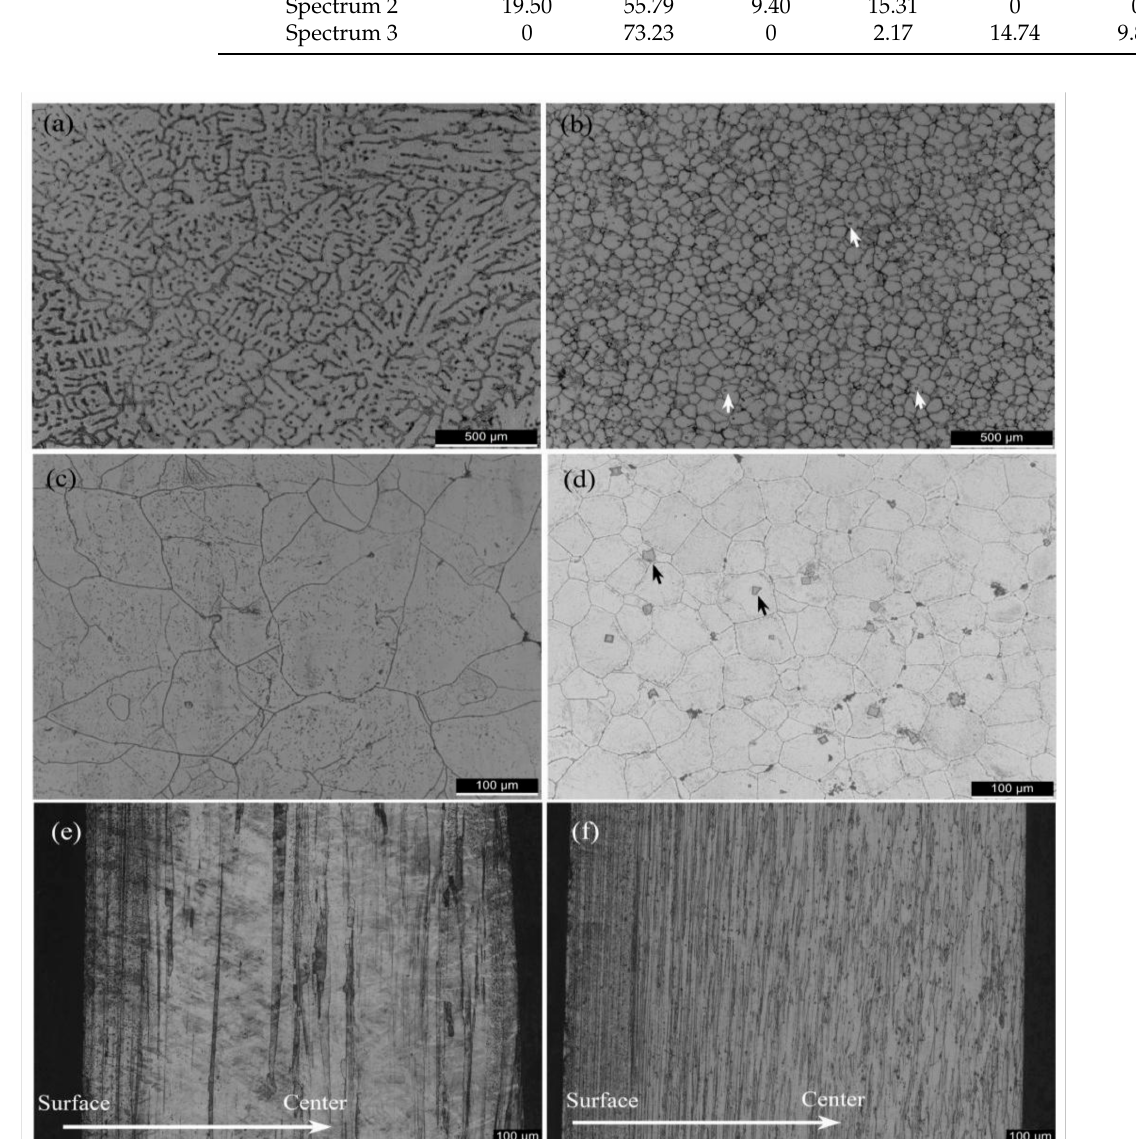
Figure 2. Optical micrographs illustrating the grain morphology of Al-Zn-Mg-Cu alloys. ( a , c , e ) Al-Zn-Mg-Cu-Zr alloy in the as-cast, homogenization, and hot-extrusion condition, respectively, ( b , d , f ) Al-Zn-Mg-Cu-Sc-Zr alloy in the as-cast, homogenization, and hot-extrusion condition,